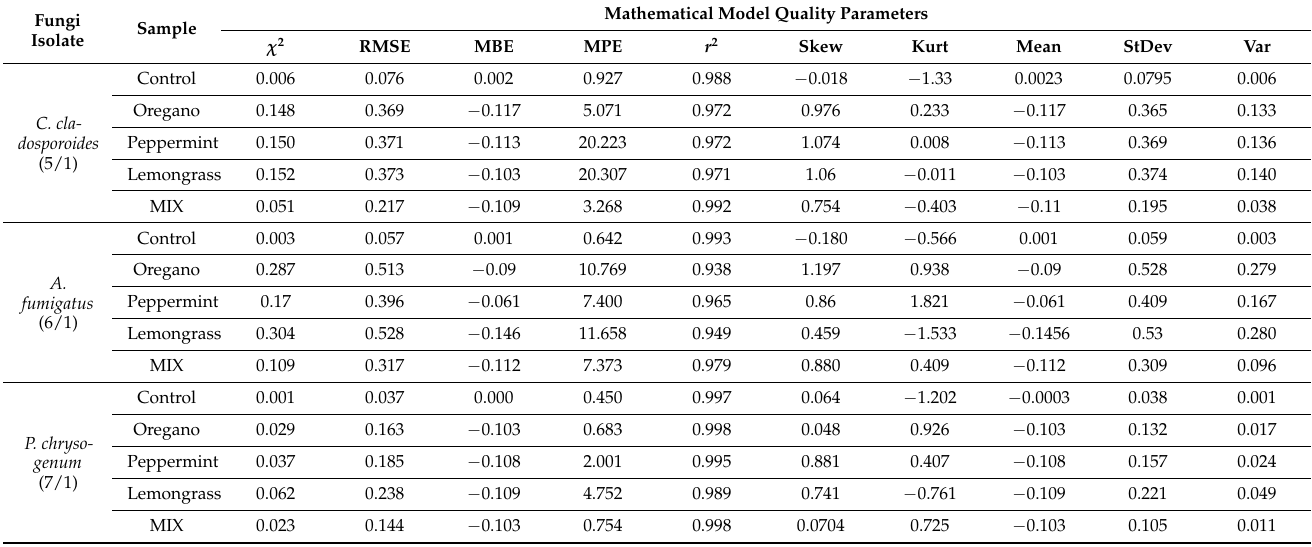
Table 4. The goodness of fit between experimental quantities and model planned